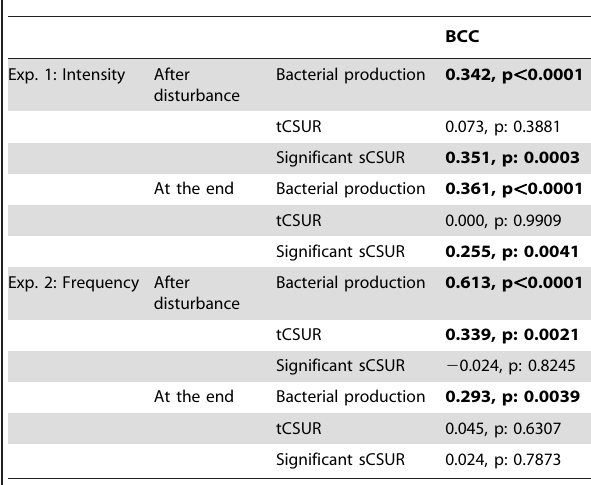
Presented are the r M values and the significance levels for correlations between bacterial community composition (BCC), bacterial production, total substrate utilization rates (tCSUR) and the rates of utilization of significant substrate guilds (significant sCSUR). Bold text indicates significant correlations (p # 0.05).